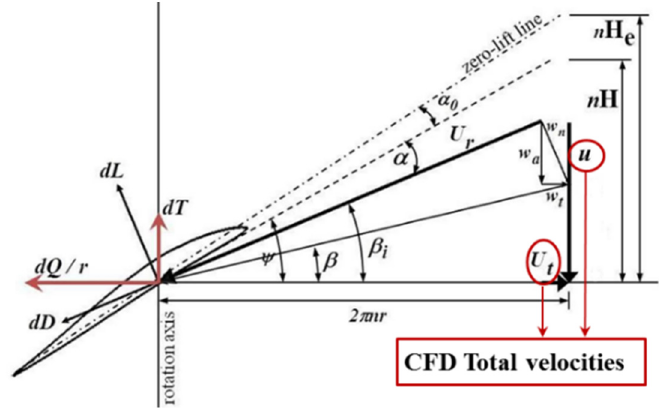
Figure 1. Blade element theory